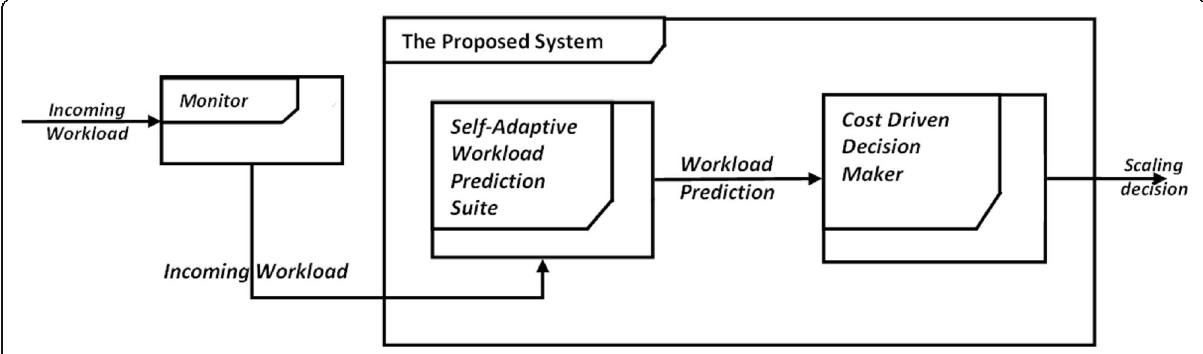
Fig. 2 Predictive Auto-scaling system